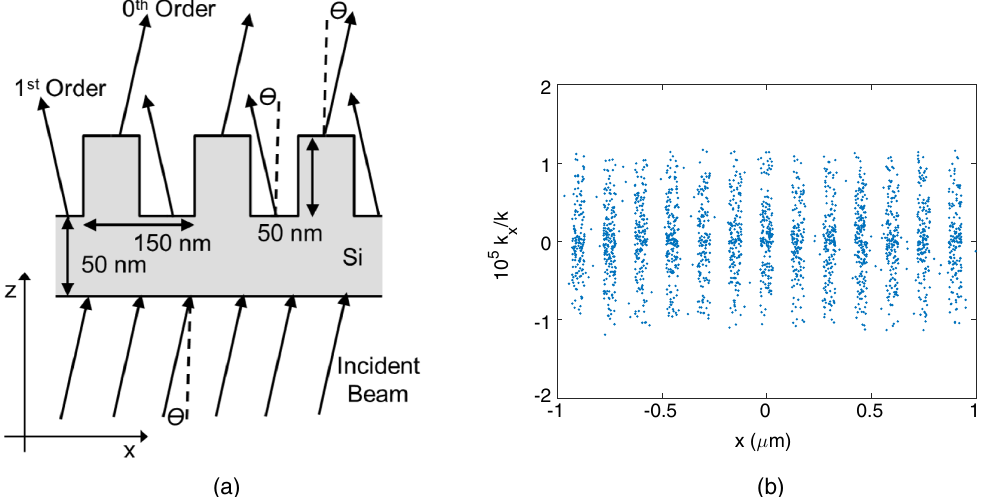
FIG. 3. (a) The single crystal Si grating. (b) The forward scattered (0th order) electron beam (with mean transverse momentum equal to the Bragg angle removed).